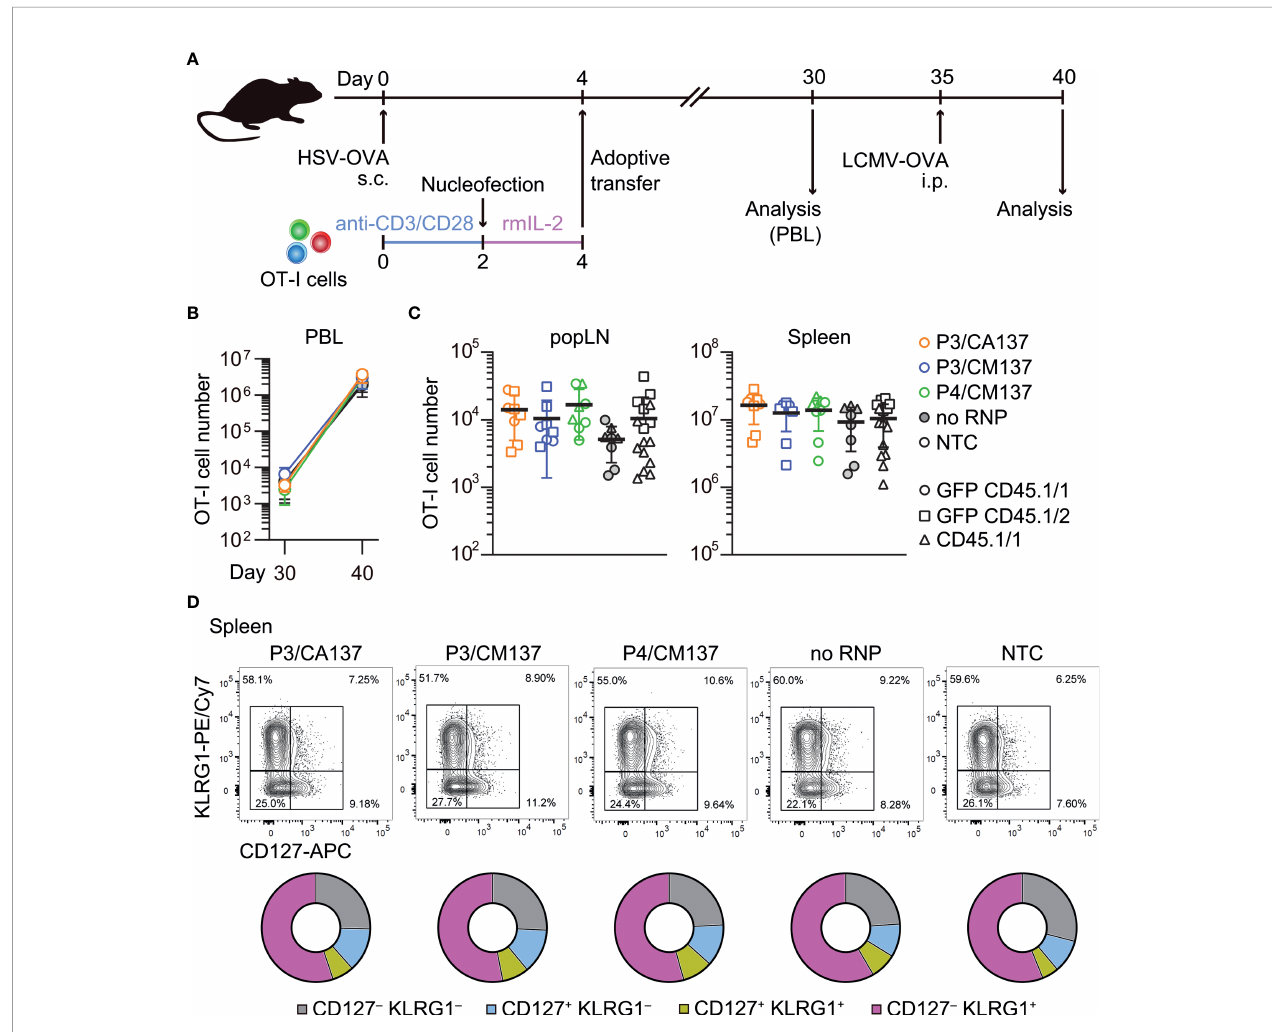
FIGURE 4 | Recall responses of memory OT-I cells generated from in vitro -activated, nucleofected OT-I cells. (A) Experimental scheme. Mice were treated in the same manner as in Figure 2 . On day 30, peripheral blood leukocytes (PBL) were analyzed to determine the number of OT-I cells before secondary infection with 10